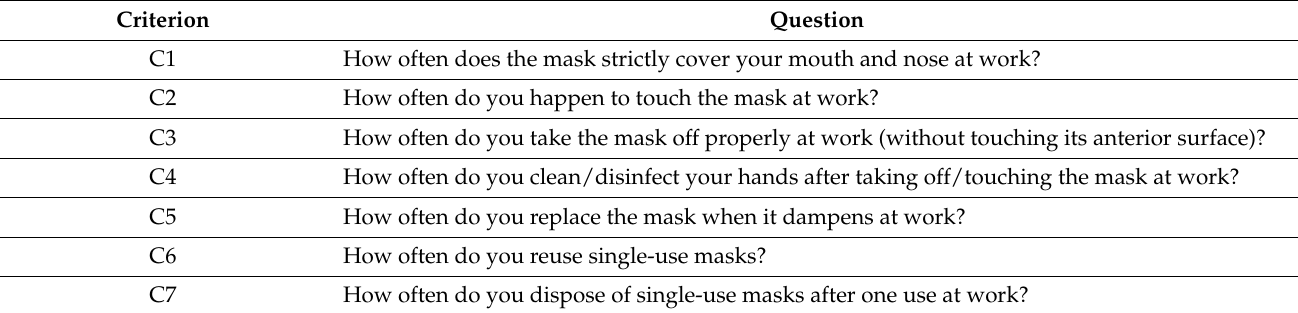
Table 1. Questions used in the survey based on WHO guideline criteria concerning the correct use of face masks.